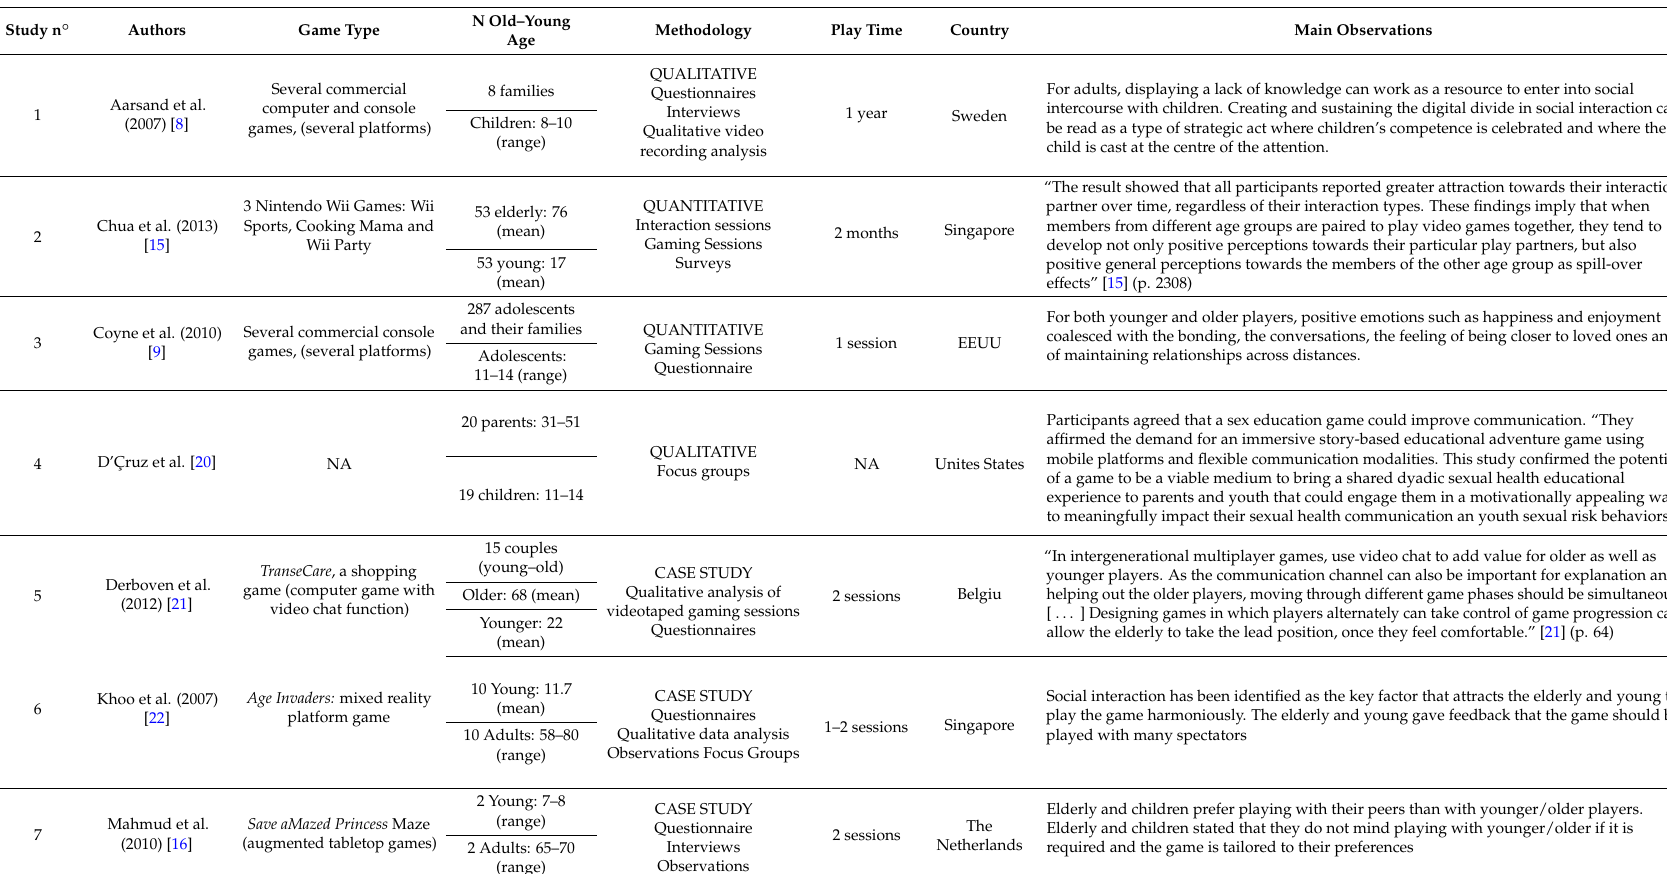
Table 1. Overview of empirical studies of digital intergenerational gaming